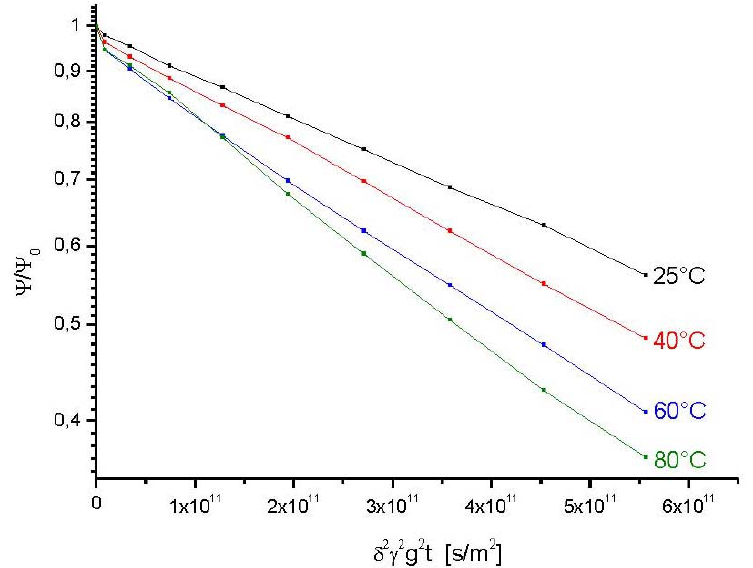
Figure 5. PFG NMR attenuation curves of propane in zeolite NaCa-LTA-0 for an observation time of 20 ms for different